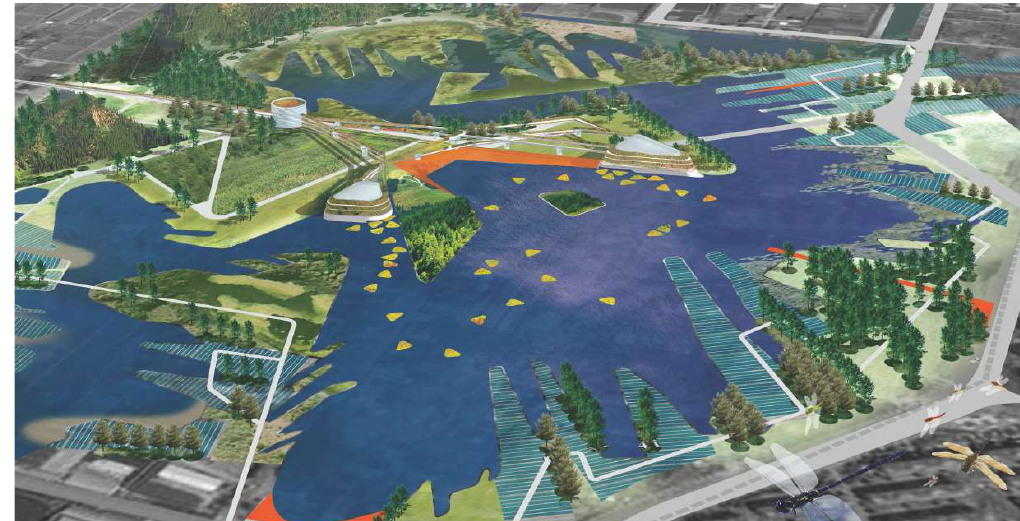
Figure 4. The Qing Ting (Dragon Flies) team’s design applying landscape-first ideas for Chongming Island, Shanghai, P.R. of China (Copyright © 2014 Jason Simms, Marina Kato, Wu Chengyi, Ya Dan, Luo, Han Liu, Hanxiao Jiang, Yiling Chen, used with permission, all rights reserved).